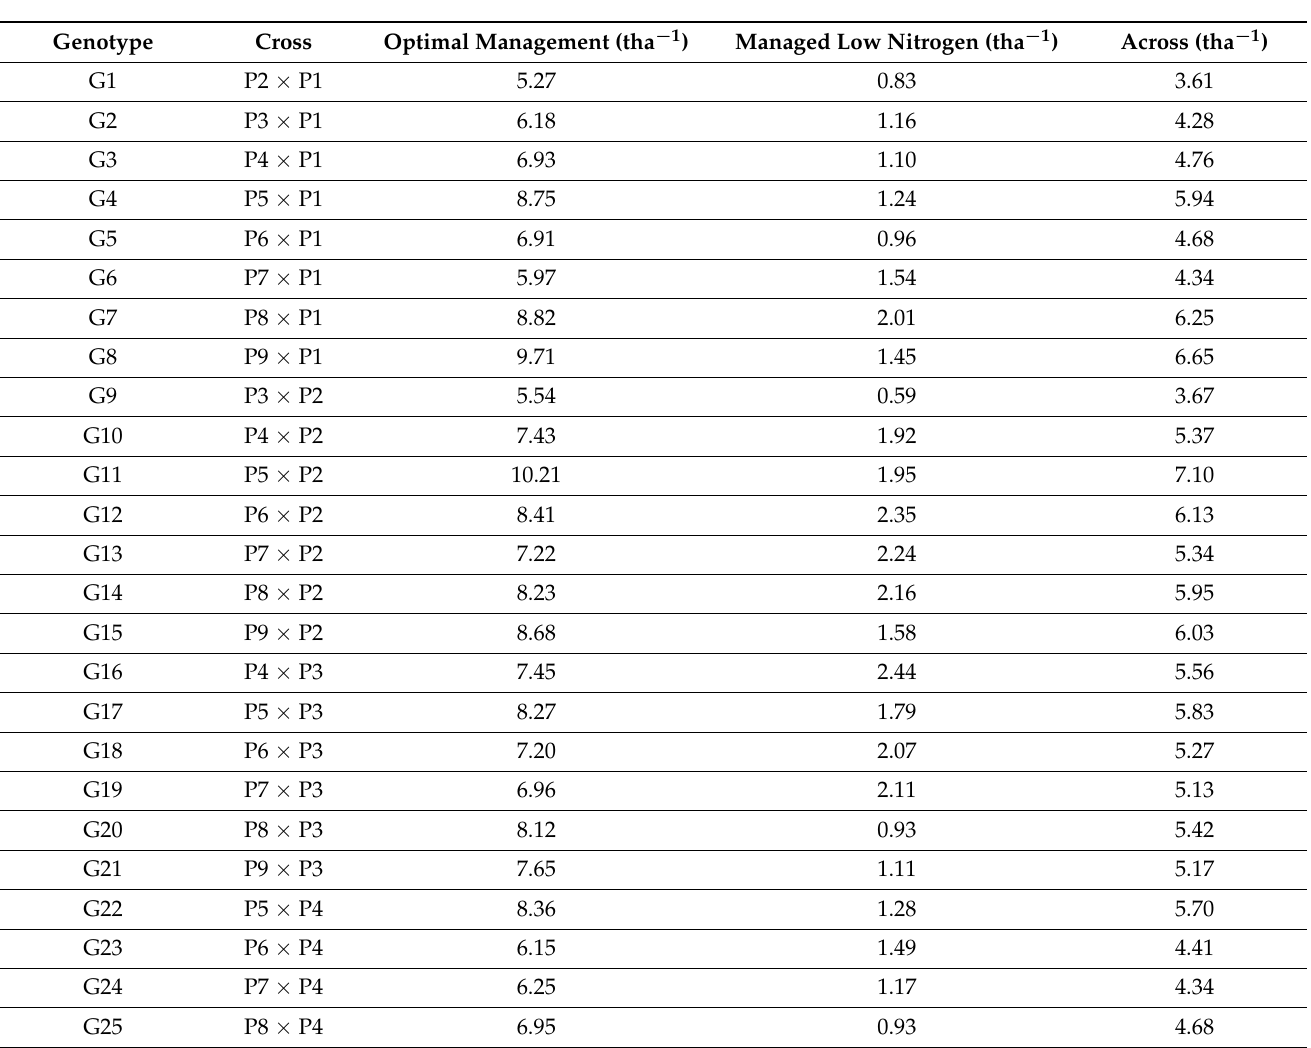
Table 6. The grain-yield performance of the 36 diallel crosses and the four check hybrids evaluated under low-nitrogen and optimal conditions in Zimbabwe and Zambia during the 2018 and